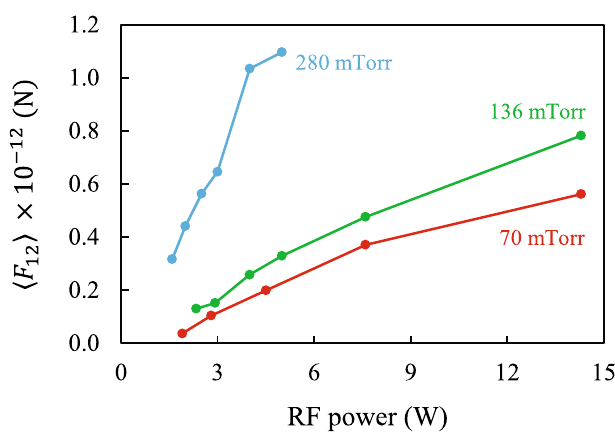
Figure 9. Estimation of the force with which the lower particle acts on the upper